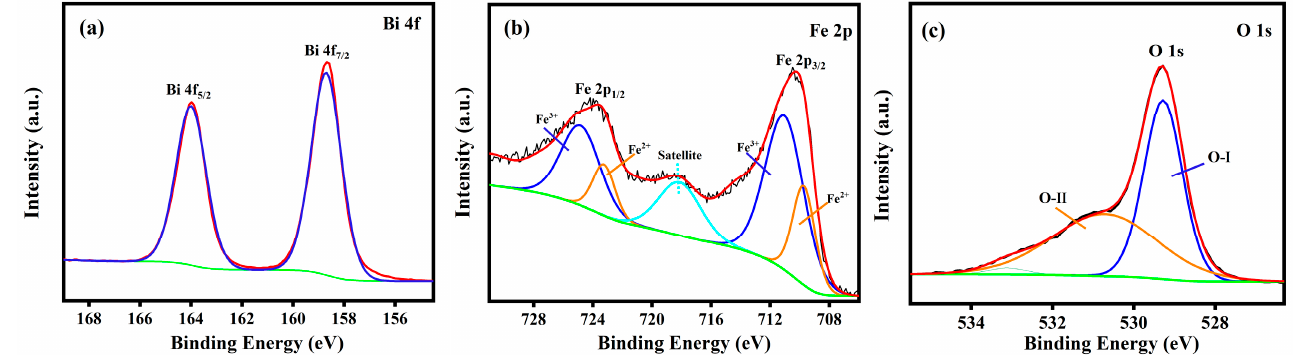
Figure 3. X-ray photoelectron spectroscopy (XPS) spectra of ( a ) Bi 4f, ( b ) Fe 2p and ( c ) O 1s for the Gd 0.5 Bi 0.5 FeO 3 sample.